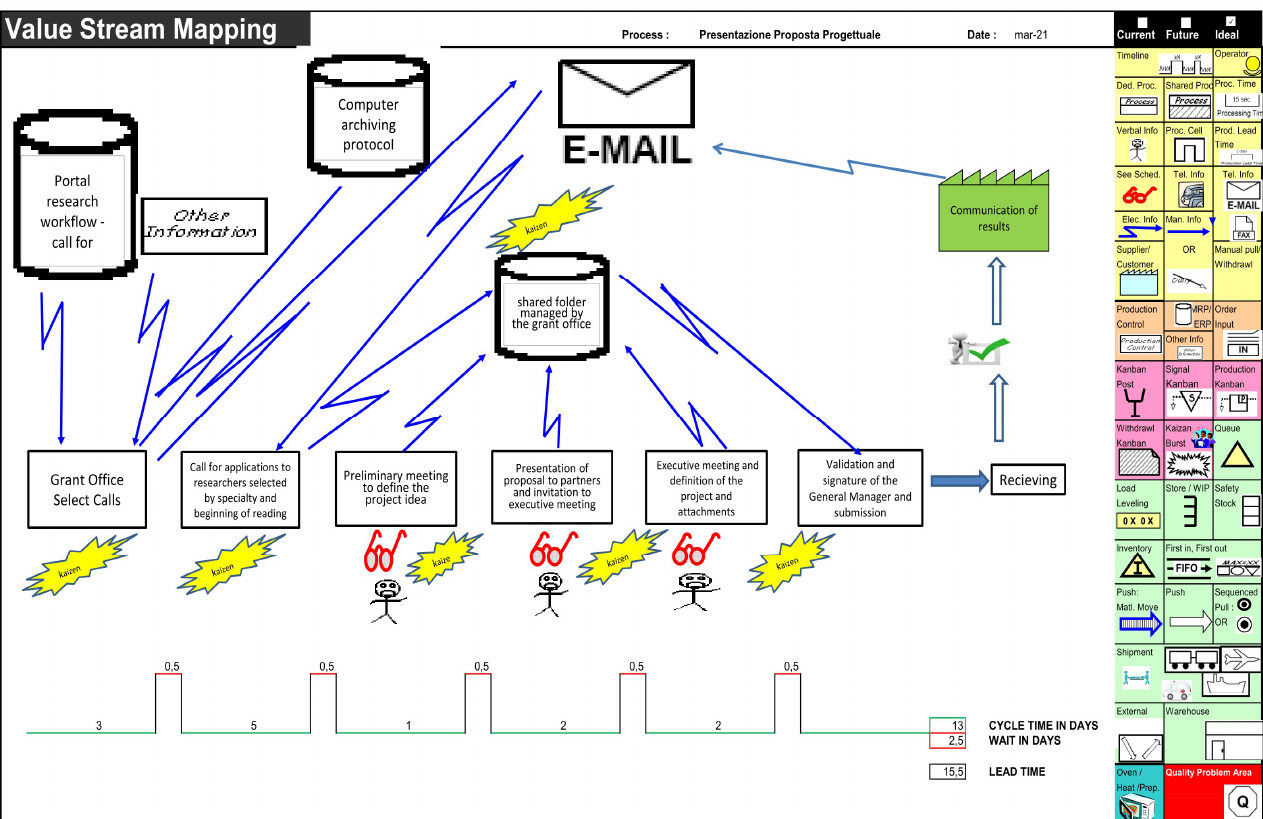
Figure 5. Future state (“to